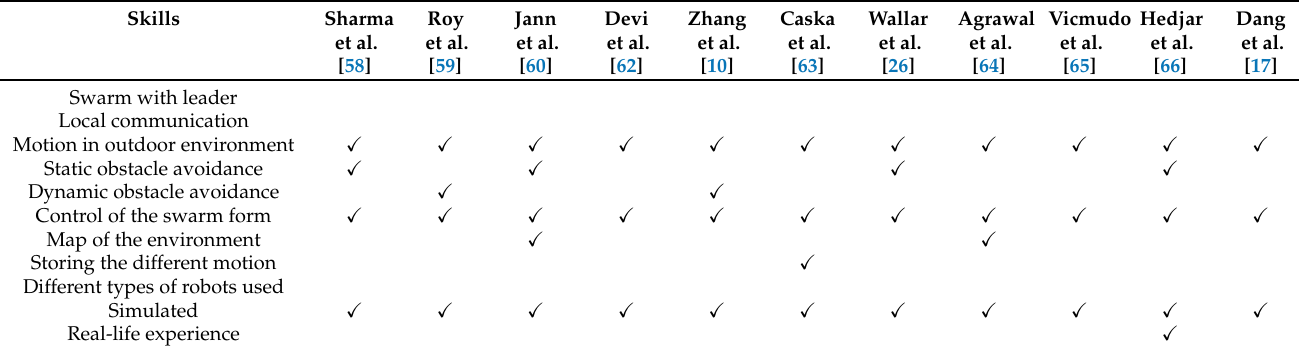
Table 4. Comparison of different heuristic algorithms for centralized